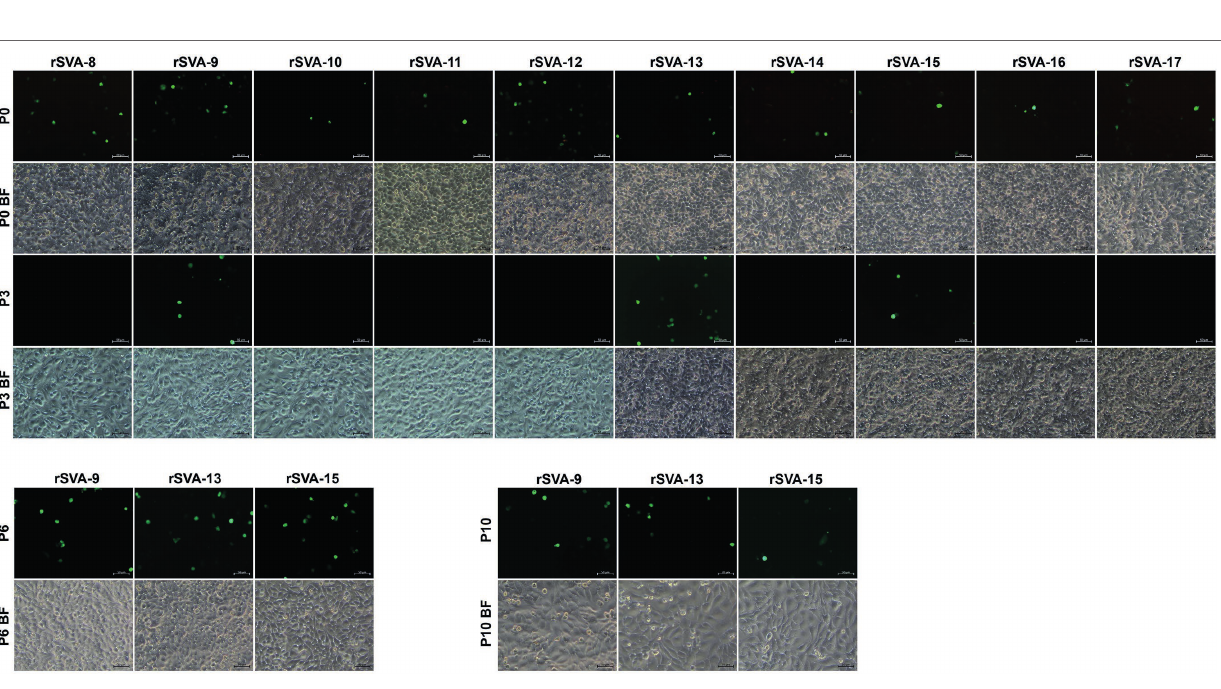
FIGURE 4 | Profiles of rSVA-8- to − 17-expressed eGFPs in BSR-T7/5 cells during passaging. Cell monolayers are separately transfected with cD-8 to − 17. At 72 hpt (P0), cell cultures undergo one freeze and thaw cycle to collect supernatants for three serial passages. Three eGFP-expressing groups (rSVA-9, − 13, and − 15) are consecutively passaged in cells until P10. BF, bright